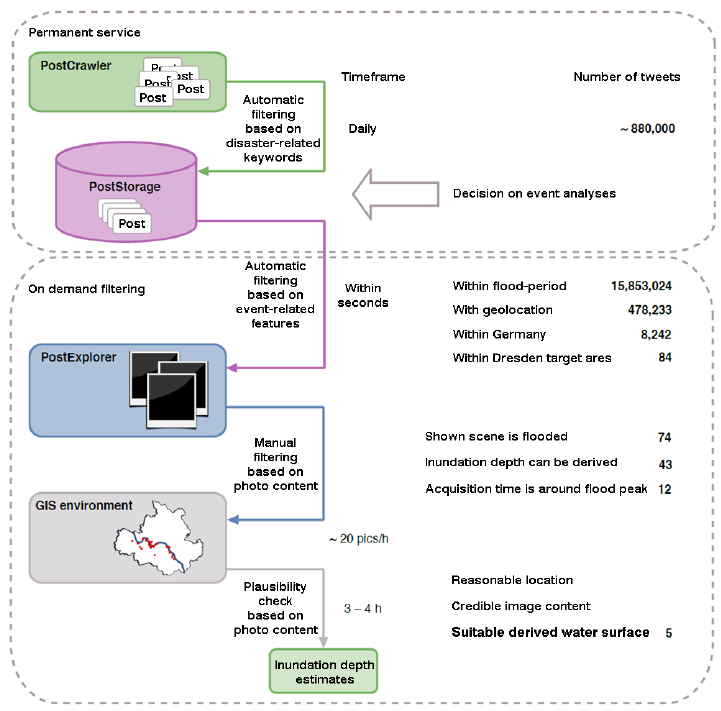
Figure 4. Process chain, time frame and number of tweets for the June 2013 Dresden flood, processed within PostCrawler, PostStorage, PostExplorer and GIS environment for the automatic and manual filtering of